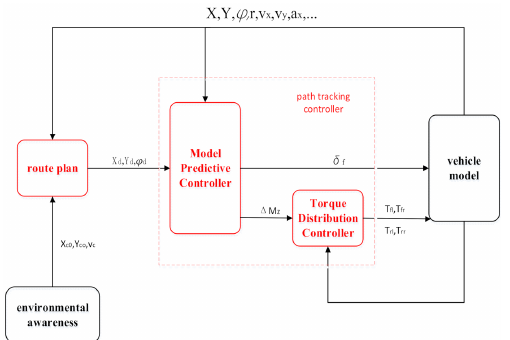
Figure 1. Vehicle control flow chart. Where, X c 0 and Y c 0 are the lateral distance and longitudinal distance from the obstacle; v c is the vehicle speed of the obstacle; X d and Y d are the expected lateral and longitudinal distance of the vehicle; ϕ d is the expected yaw angle of the vehicle; ∆ M z is the additional yaw moment; T fl , T rl , T rr and T fr are the torques of the left front wheel, the left rear wheel, the right rear wheel and the right front wheel, respectively; X and Y are the transverse and vertical coordinates under the inertial coordinate system; ϕ is the yaw angle under the body coordinate system; r is the turning radius of the vehicle; v x and v y are the lateral and speed longitudinal of the vehicle; a x is the lateral acceleration of the vehicle.